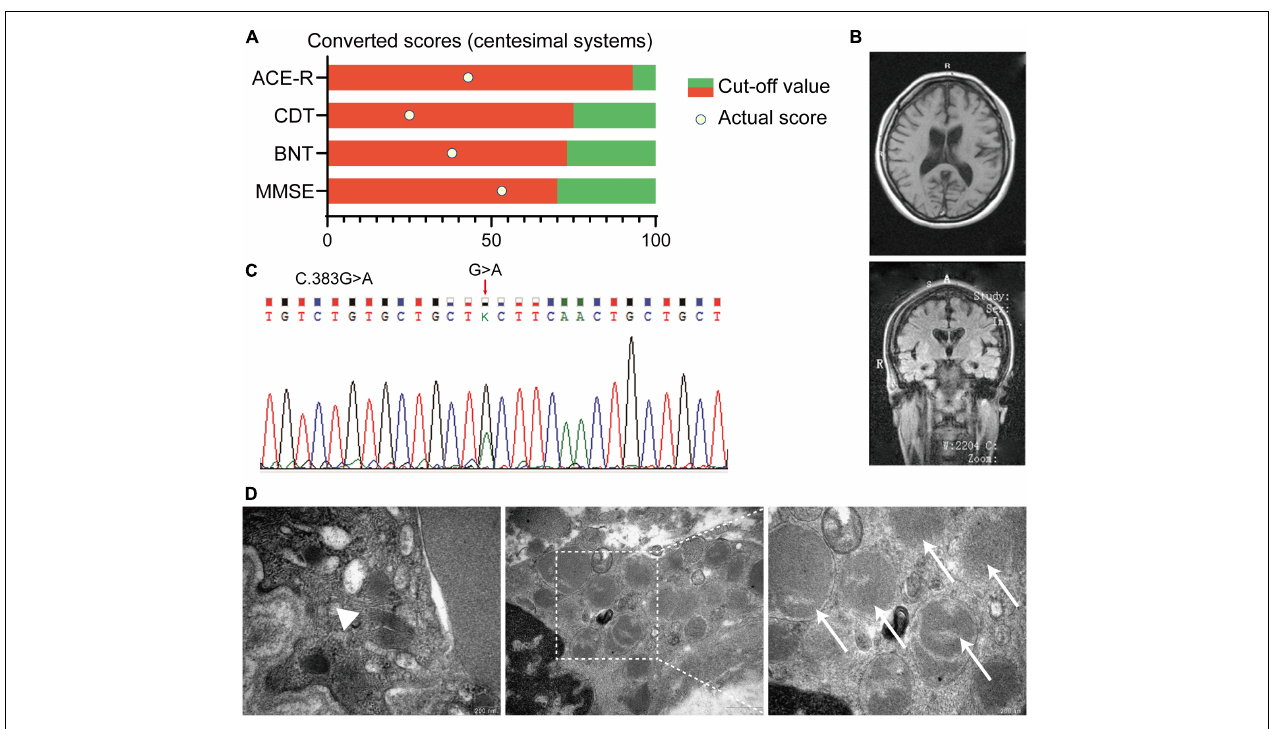
FIGURE 1 | Summary of clinical records of an affected patient with Adult-onset NCL (ANCL). (A) Neuropsychological assessments indicated the cognitive decline in this patient. Scores of each assessment were converted to centesimal systems. (B) Typical MRI imaging of the proband revealed the symmetric atrophy of the bilateral cortex (GCA scale = 2) and hippocampus (MTA scale = 2). (C) Chromatograms of the DNAJC5 genomic DNA sequence showed a coding variant at position c.383 (c.383G > A). (D) Representative pictures of the skin biopsy of sweat gland showed GRODs and curvilinear profile in the affected proband. Magnification is 65,000 × in the left and right picture, and 33,000 × in the middle one. White arrowhead: the curvilinear profile, white arrows: GRODs. MMSE:, mini-mental state examination; BNT, Boston naming test; CDT, clock drawing test; ACE-R, Addenbrooke’s cognitive examination; GRODs, granular osmiophilic deposits; GCA, global cortical atrophy; MTA, medial temporal lobe